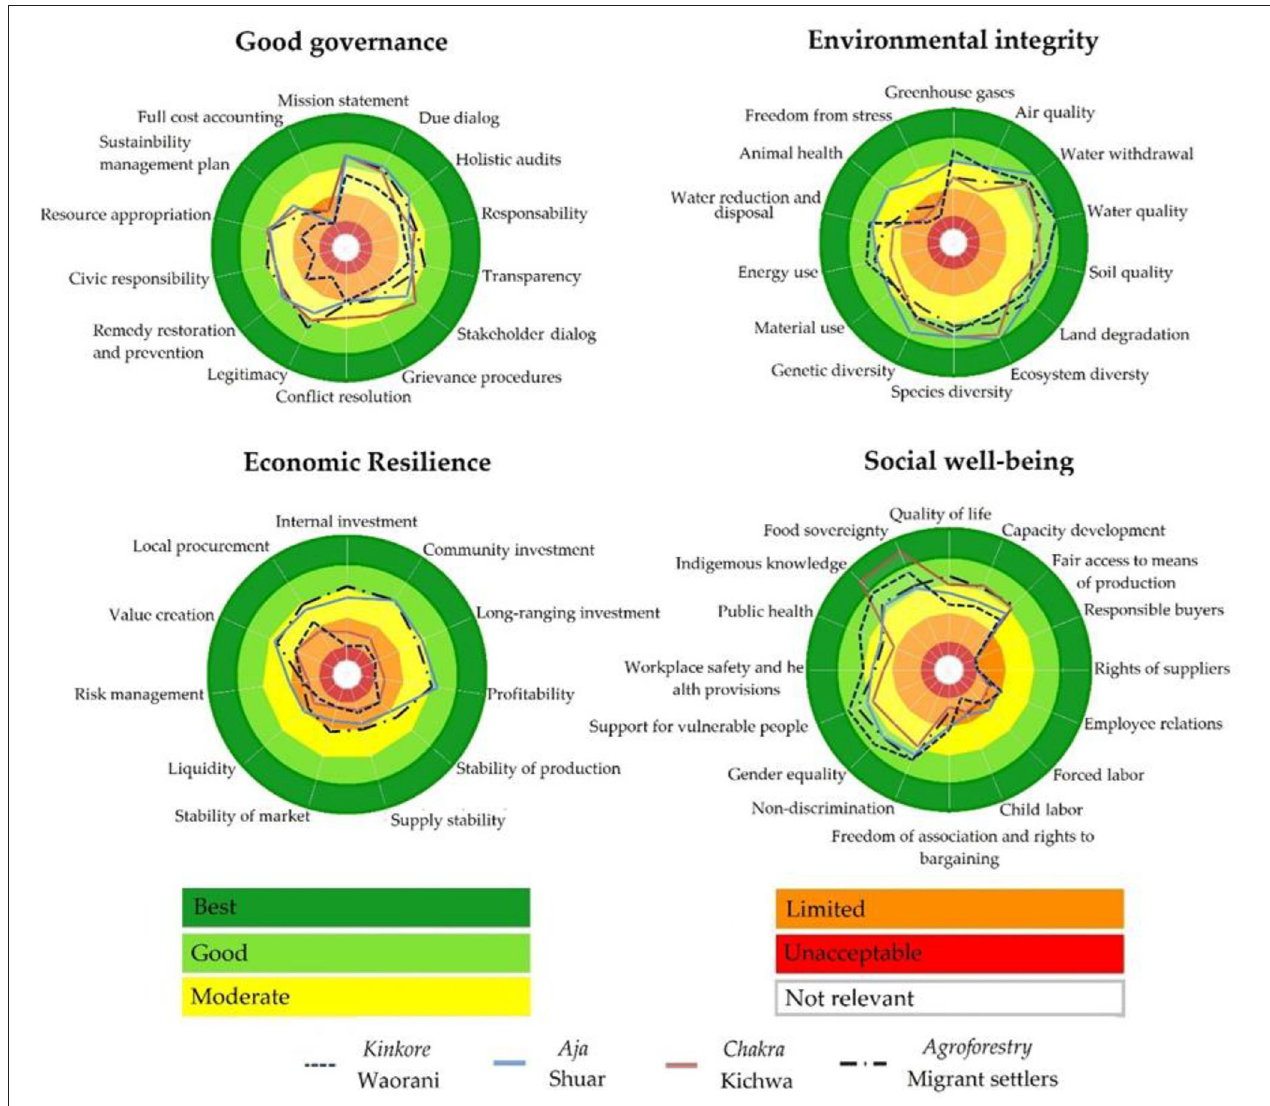
FIGURE 2 | Comparison of the dimensions of good governance, environmental integrity, economic resilience, and social well-being in the four traditional production systems in the Yasuní Biosphere Reserve, Amazon region of